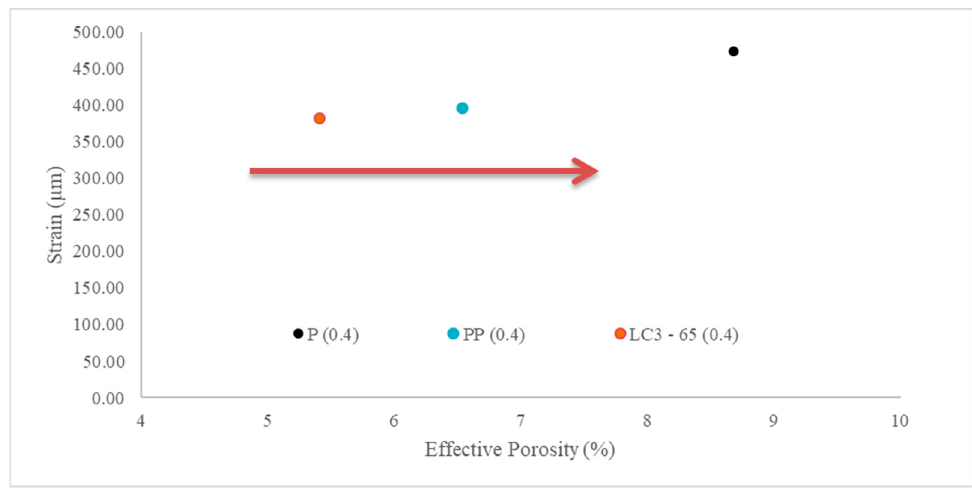
Figure 12. Effective Porosity vs. strain.